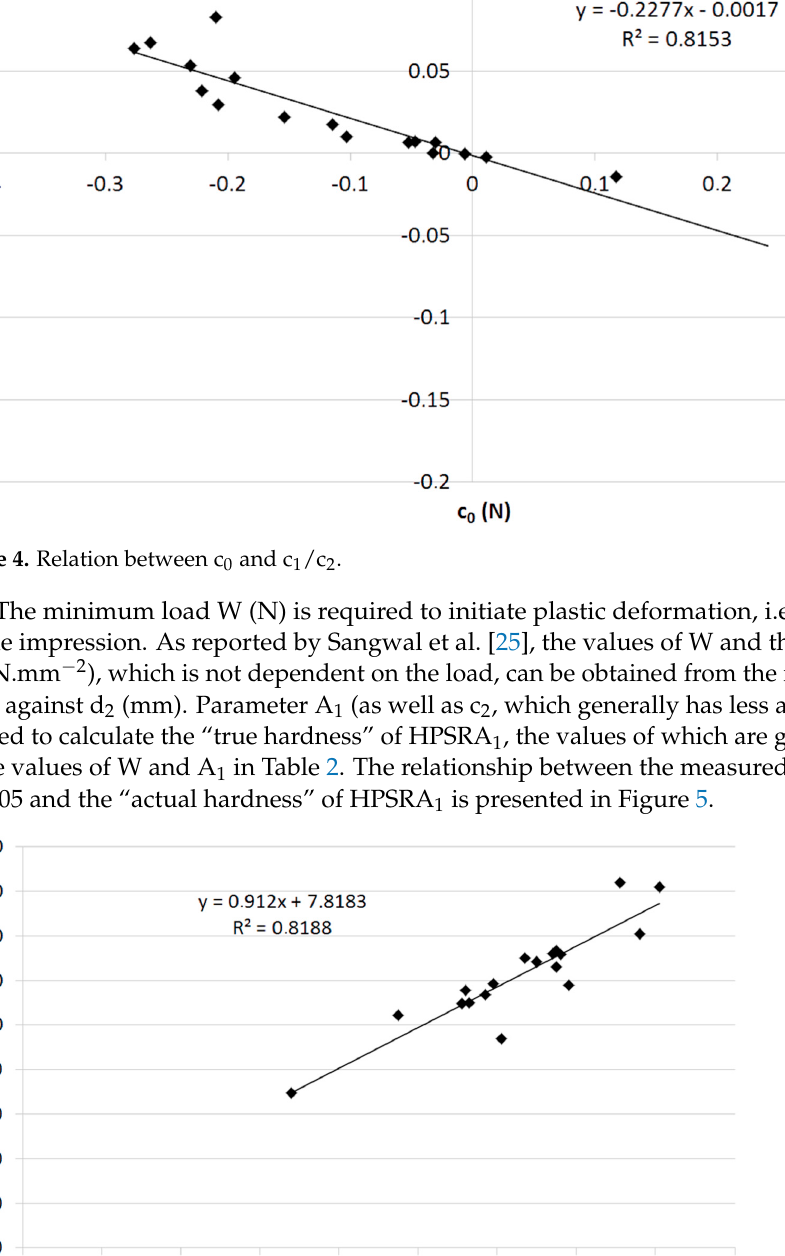
Figure 5. Relation between HV0.05 and HPSRA 1 .